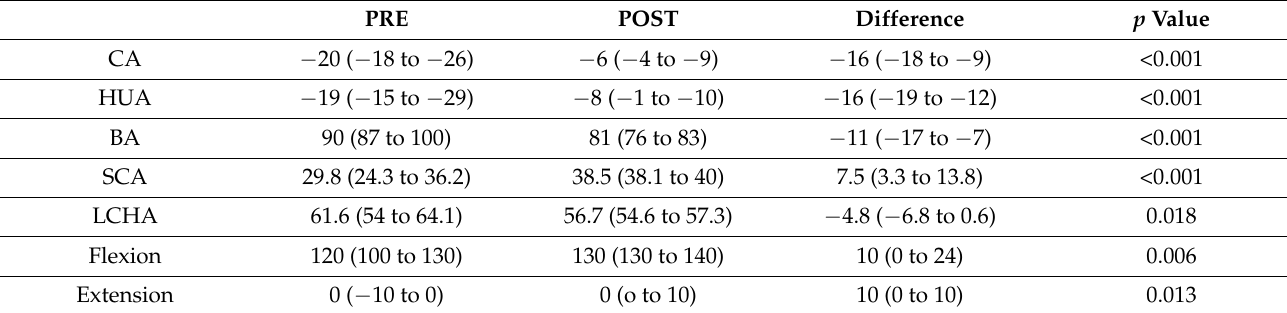
Table 1. Pre- and post-clinical and radiological measurements.